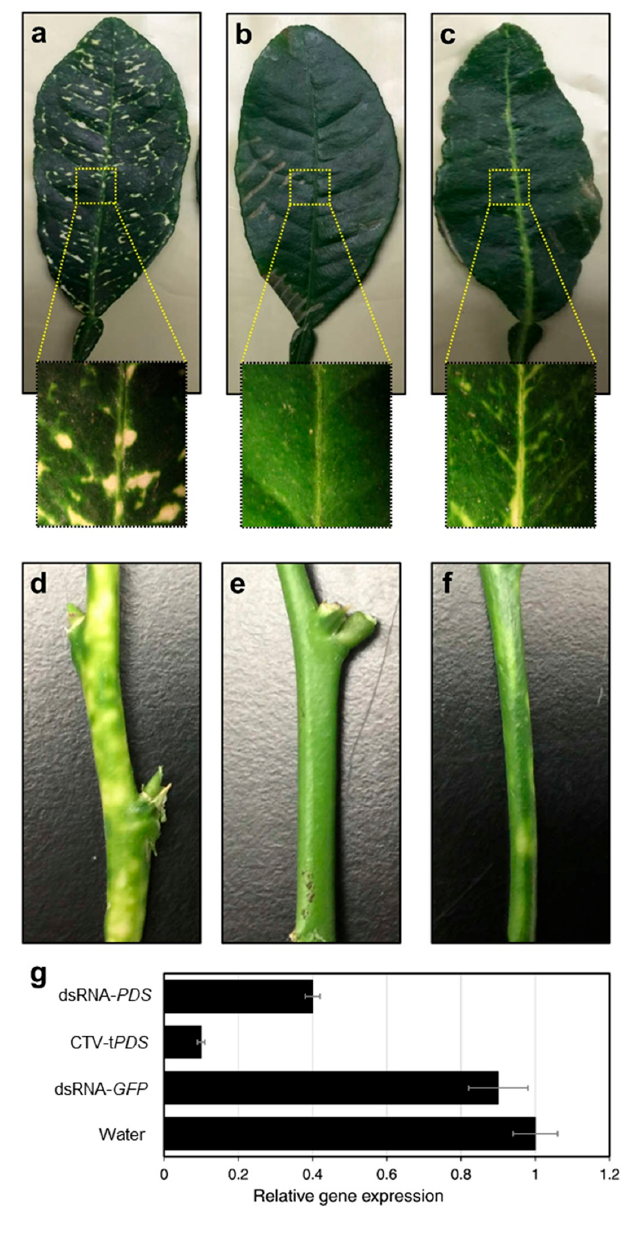
Figure 2. Color bleaching and relative gene expression of PDS in citrus leaves after delivery of dsRNA- PDS thought laser micro-perforation. ( a – c ) Photobleaching in leaves of CTV-t PDS